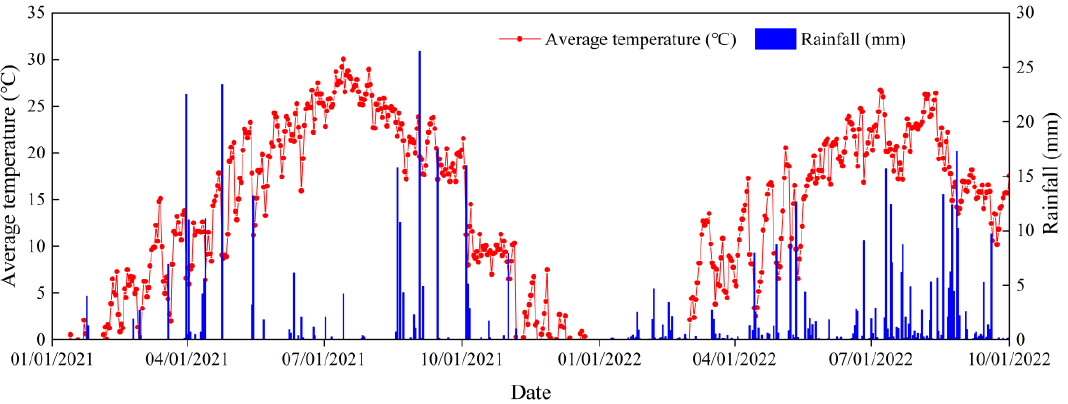
Figure 2. Temperature and rainfall during the potato fertility period in the experimental area.